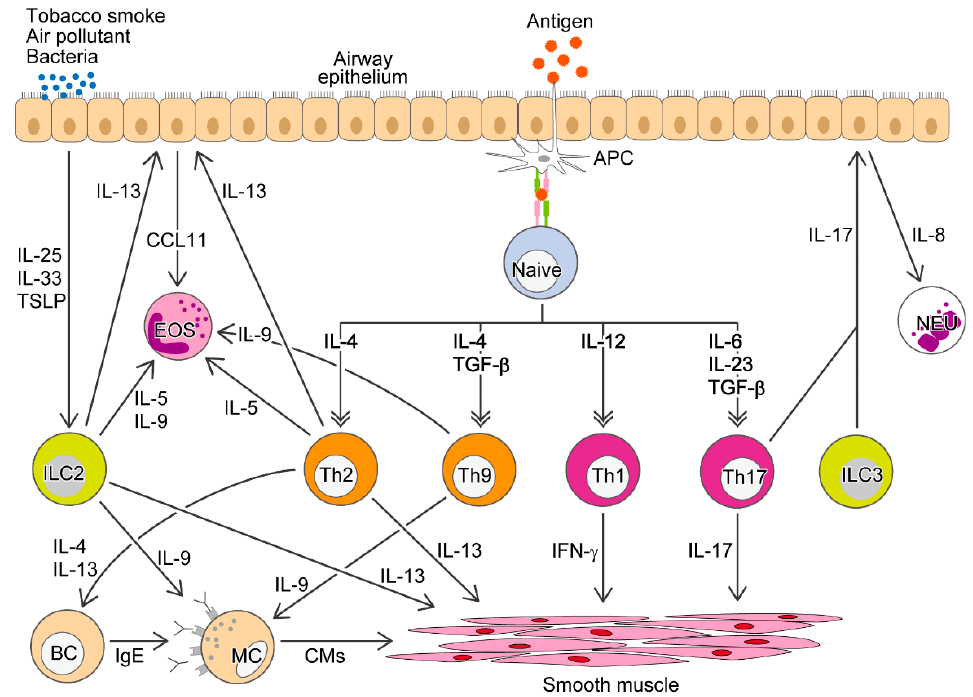
Figure 1. Key players in the development of allergic airway inflammation. Foreign antigens exposed to airway epithelium are processed and presented by APCs to unprimed naive CD4 + T cells. Then the naive CD4 + T cells differentiate into various Th cell subsets, largely depending on their respective cytokines in the surrounding environment. Individual Th subsets produce their characteristic cytokines and contribute to the development of allergic airway inflammation. The involvement of new lymphoid cells such as group 2 innate lymphoid cells (ILC2) and ILC3 has recently been reported. BC, B cell; EOS, eosinophil; CMs, chemical mediators; MC, mast cell; NEU, neutrophil; TSLP, thymic stromal lymphopoietin.